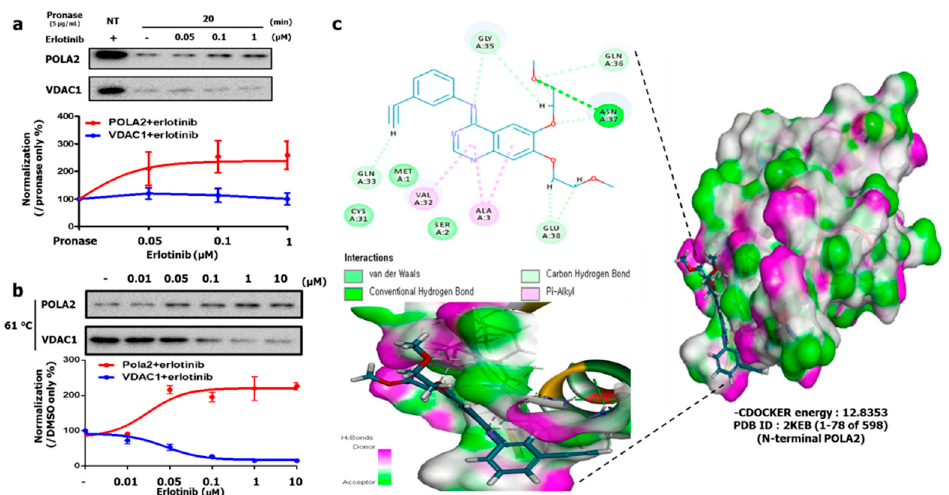
Figure 3. Identification of POLA2 as a new Erlotinib binding protein. ( a ) DARTS assay validating the Erlotinib-POLA2 interaction. POLA2 protein was stabilized in the presence of pronase after Erlotinib treatment in H1299 cells. Pronase treatment was applied for 20 min with Erlotinib in a dose-dependent manner; ( b ) CETSA validation of the erlotinib-POLA2 interaction. POLA2 protein was stabilized under heat treatment (61 °C for 5 min) and different Erlotinib treatments in a dose-dependent manner; ( c ) In silico docking analysis of the interaction between Erlotinib and POLA2 (human N-terminal POLA2, RCSB PDB ID: 2KEB). Erlotinib binds to the TYR34-surrounded POLA2 pocket in the most stable position; binding motifs are depicted as several high-affinity interactions between Erlotinib and the POLA2 pocket. Ligands are shown as gray sticks in charge receptor surfaces. Bonds are shown as dashed lines color-coded as in ( c ).